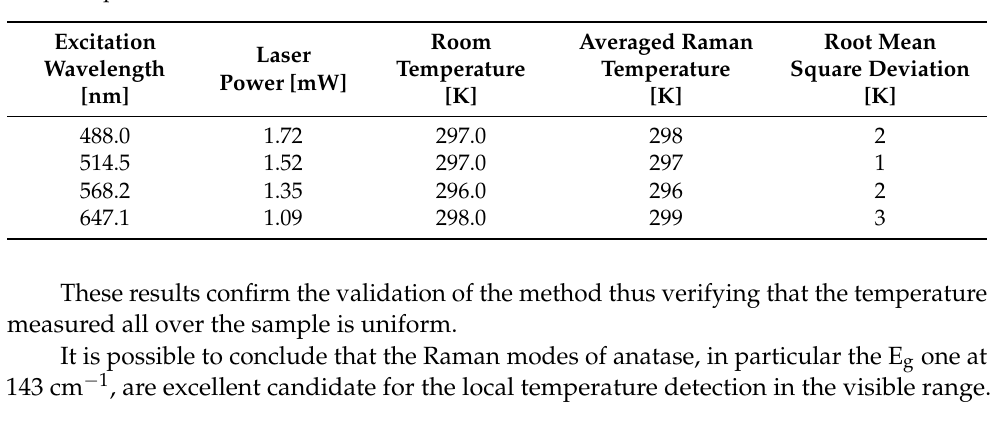
Figure 9. ( a ) Temperature determined from the anti-Stokes/Stokes values of the 143 cm − 1 E g mode at λ exc = 514.5 nm of the Test Sample , with the mean value (solid line) and the standard deviation (dashed lines); ( b ) difference between the temperature derived from the anti-Stokes/Stokes ratio (corrected with the proper calibration constant) for the 143 cm − 1 E g mode of anatase as function of the laser power incident on the sample at 488.0 (blue squares), 514.5 (green diamonds), 568.2 (yellow triangles) and 647.1 nm (red circles). The dashed line represents the room temperature. Table 7. Results of repeated measurements at four different excitation wavelengths conducted at room temperature.